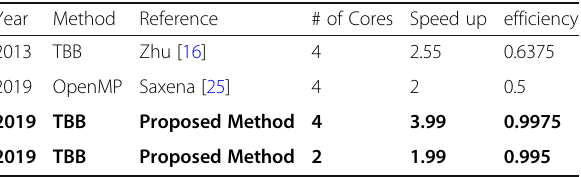
Table 3 Comparing the efficiency of state-of-art parallelizations of GA solution of